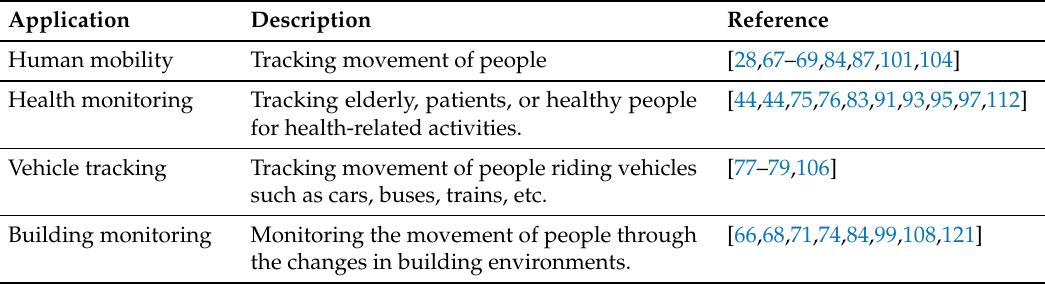
Table 4. Taxonomy of barometer applications to track human